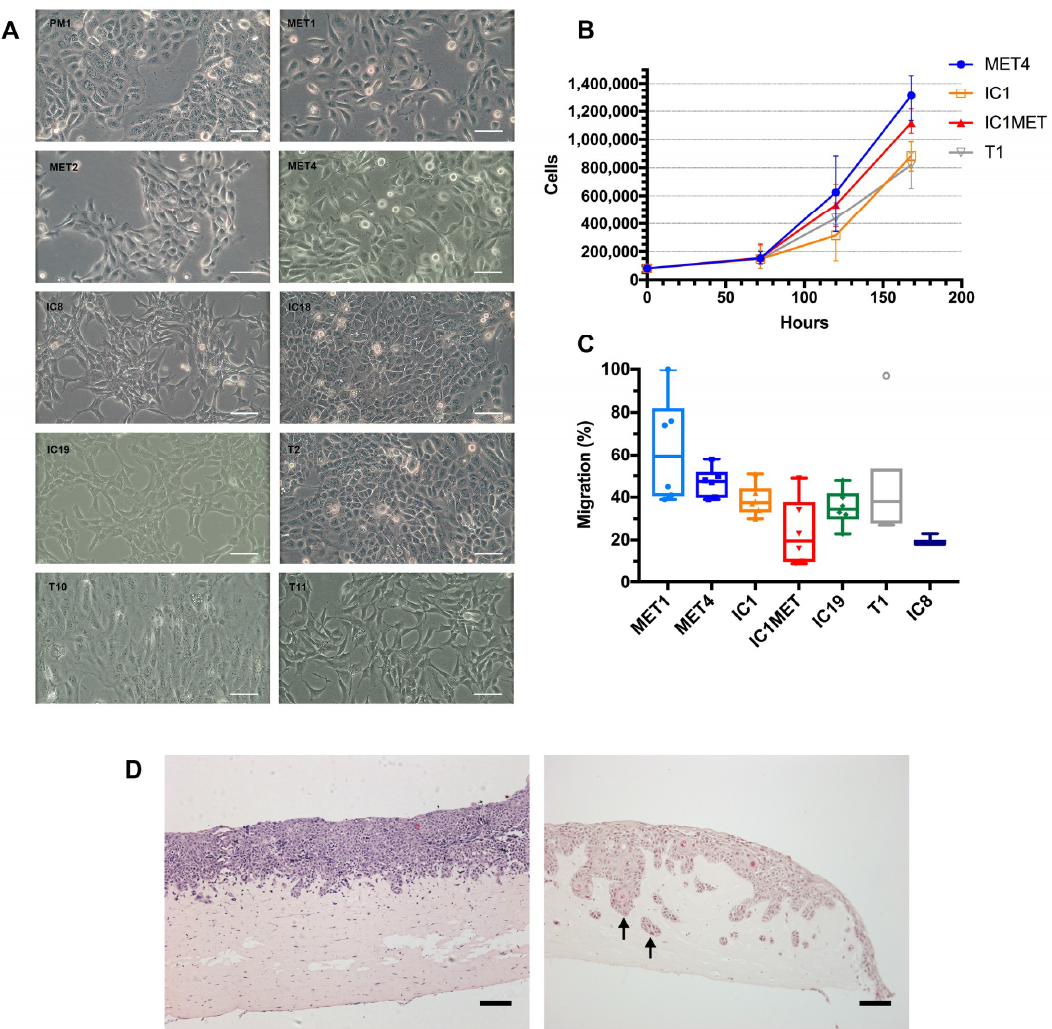
Figure 2. cSCC cell line characterisation. Phase contrast images demonstrate that the cSCC cell lines have distinct morphologies based on the differentiation status of the tumours from which they were derived and their metastatic potential ( A ). The growth rate of two metastatic, MET4 and IC1MET, and two primary, IC1 and T1, cSCC lines; two of which were isogenic lines, IC1MET/IC1 ( B ). Transwell migratory potential of a selection of the cSCC lines, including four immunocompetent patient-derived and three immunosuppressed transplant recipient-derived lines; representing two separate isogenic line pairs, IC1 / IC1MET and MET1 / MET4, alongside three primary lines ( C ). Organotypic hematoxylin and eosin (H&E) images of two immunocompetent cSCC lines, IC8 and IC1. IC1 was derived from a tumour that went on to metastasise. Invading cells are shown by arrows ( D ). Scale bars = 100 μm.